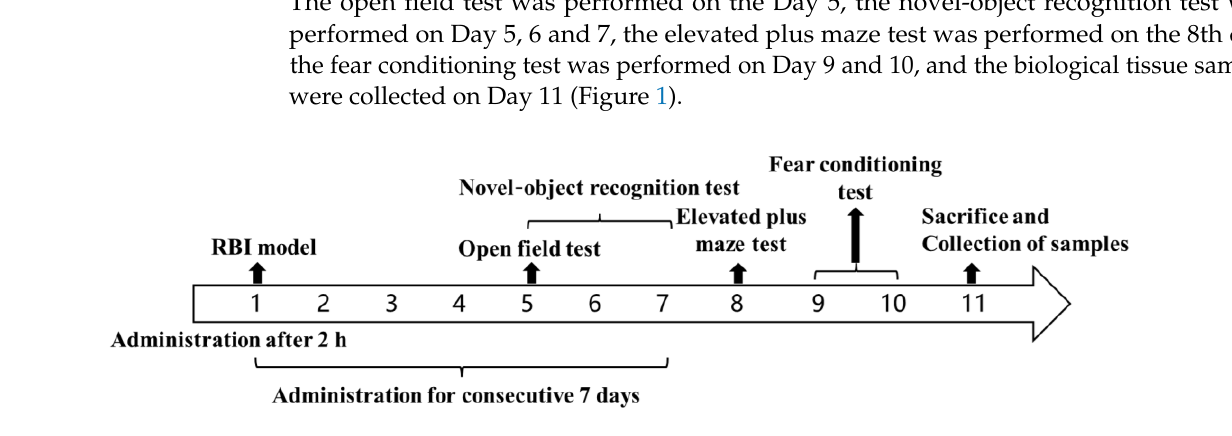
Figure 1. The schematic diagram of the pharmacodynamics test for the treatment of